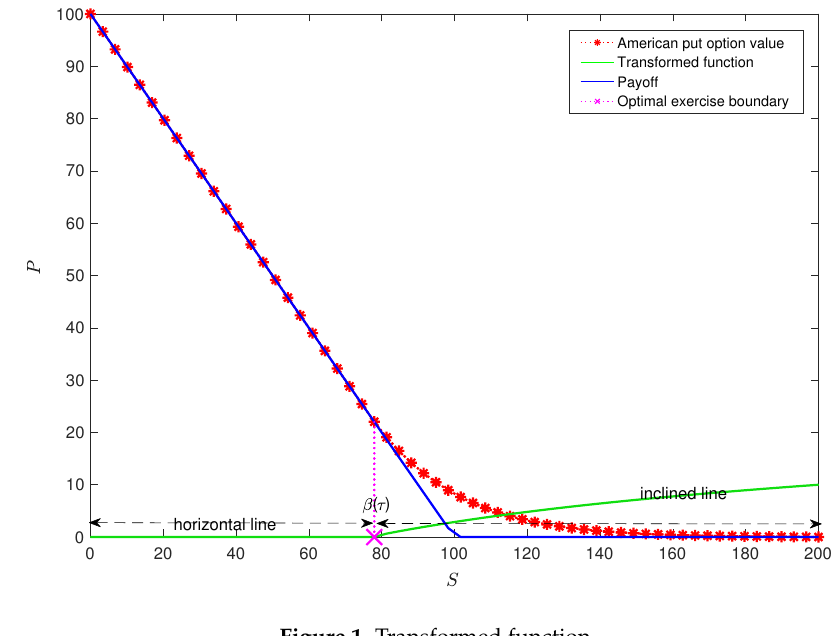
Figure 1. Transformed